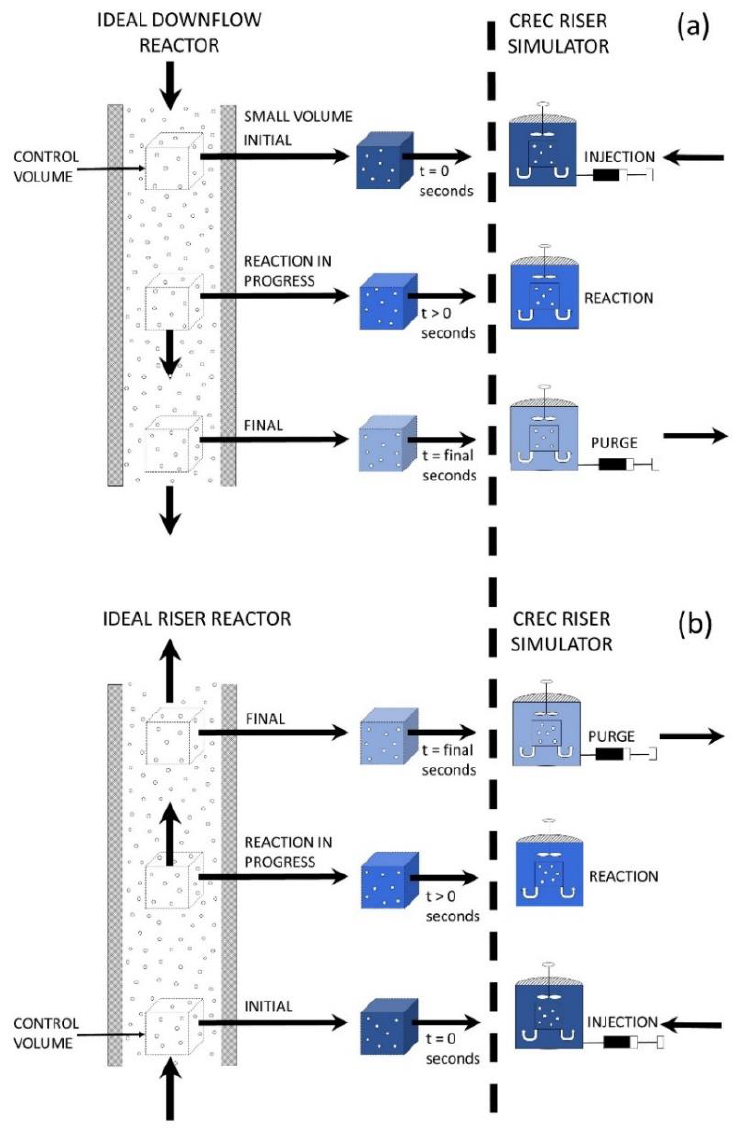
Figure 1. Comparison of the Chemical Species Concentration Changes in ( a ) downer reactor, ( b ) riser reactor and in the CREC Riser Simulator at similar reaction times.